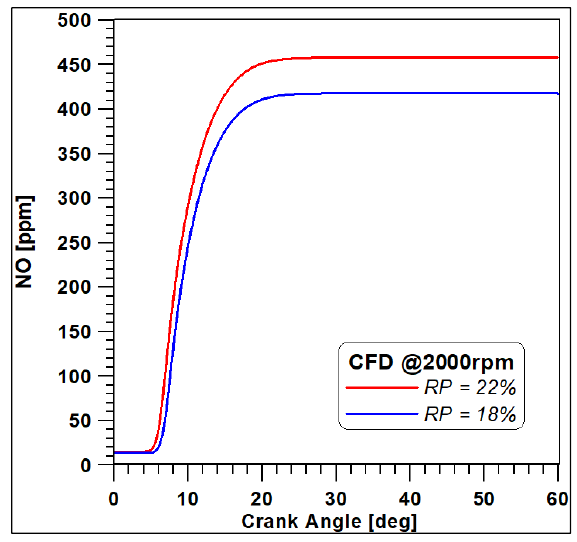
Figure 19. Numerical NO fraction for RP = 22 and 18% at 2000 rpm cases.